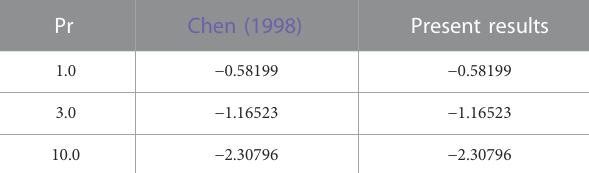
TABLE 2 Impacts of Nb , Nt, and γ on Re − 1 2